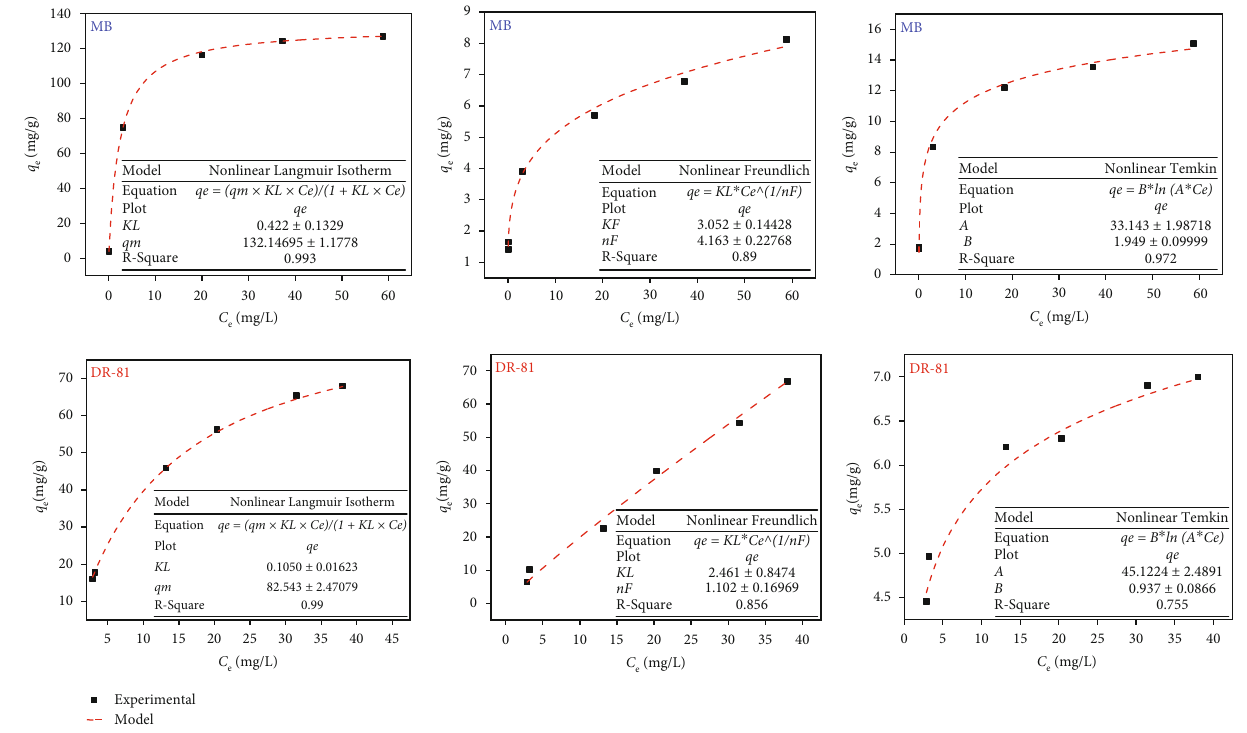
Figure 13: Adsorption isotherms for MB and DR-81 by the synthesized bio-MOF. Table 2: Isotherm parameters of the Langmuir, Freundlich, and Temkin models for the decolorization of MB and DR-81 by the synthesized